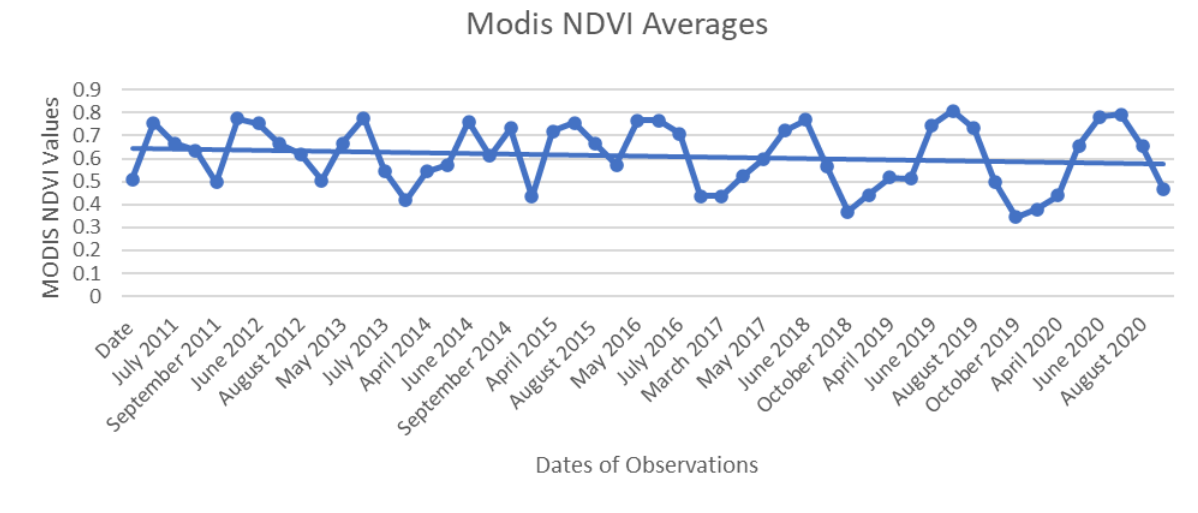
Figure 4. line graph of average of the eight MODIS point values that were within 0.5° of each GRACE point in and tangential to the Mississippi Delta from 2011 to